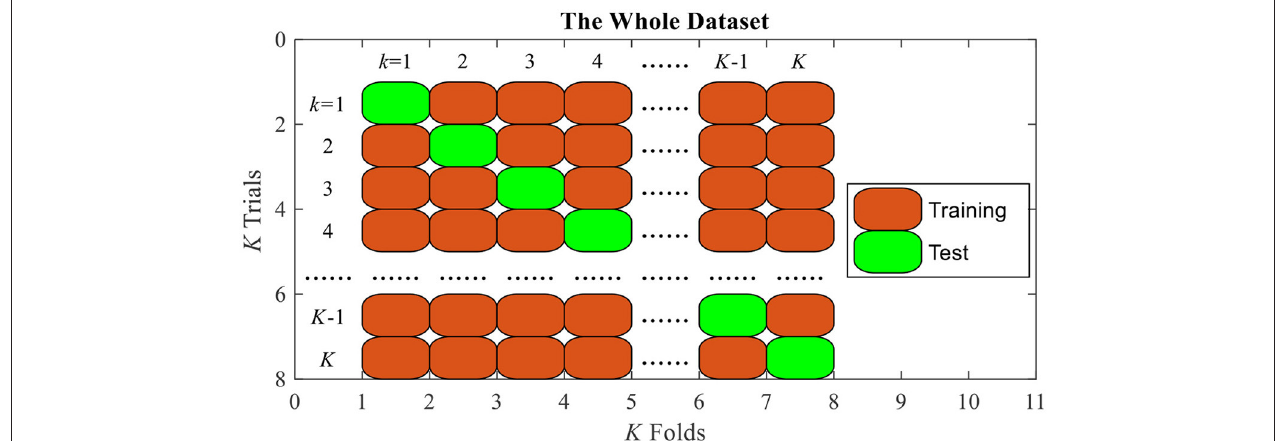
FIGURE 10 | Illustration of K -fold CV.